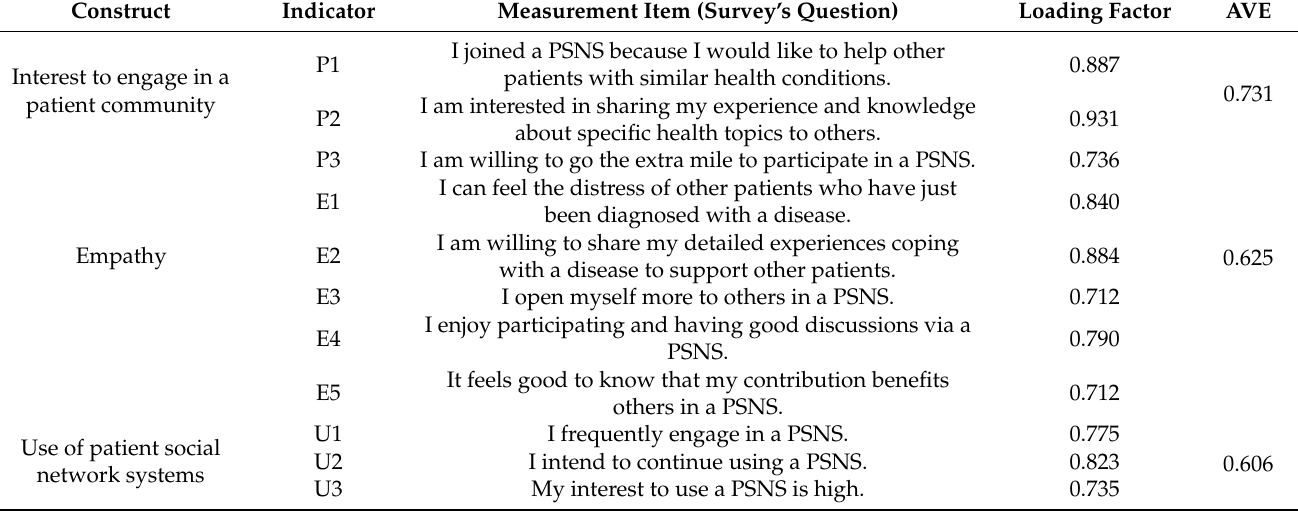
Table 2. Construct, measurement item, loading factor, and average variance extracted